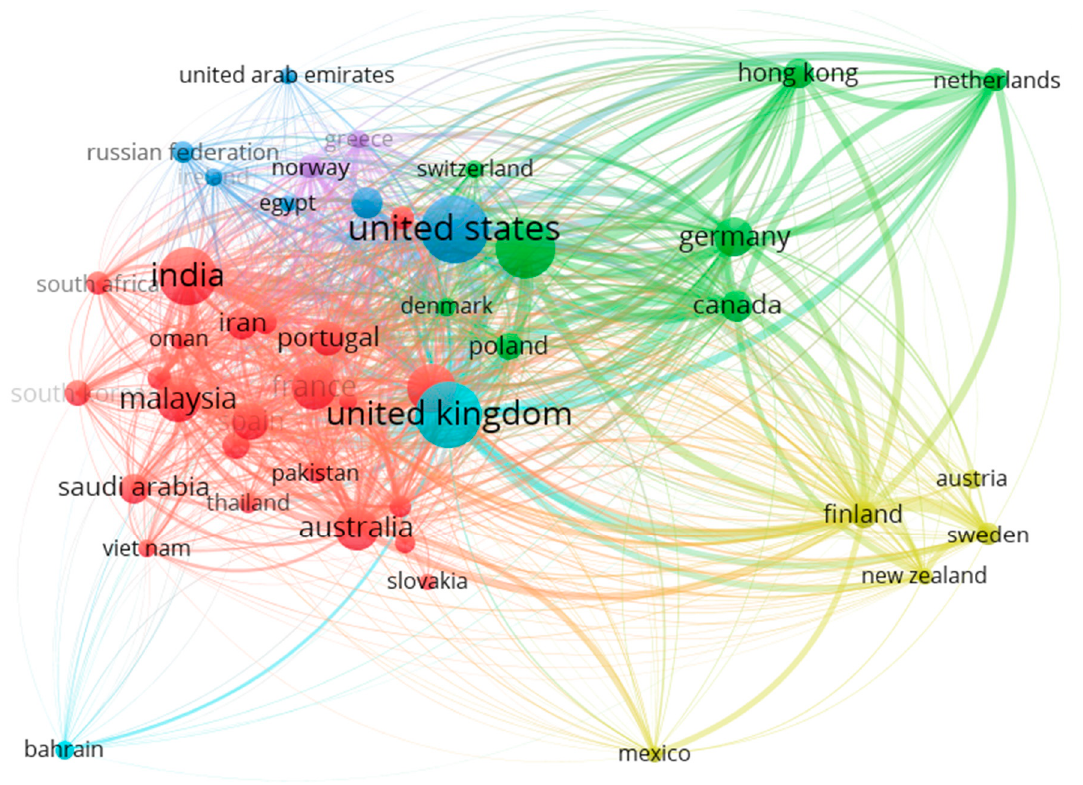
Figure 8. Bibliographic coupling based on documents.